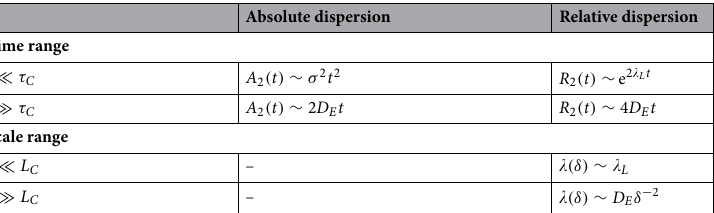
Table 1. Expected dispersion properties for the case study under consideration. Notice: τ C is the correlation time, L C is the correlation length, σ 2 is the velocity variance, D E is the eddy-diffusion coefficient and (cid:31) L is the maximum Lagrangian Lyapunov exponent, A of absolute and relative dispersion, respectively, and (cid:31) (δ) is the FSLE. Relation to model parameters: τ